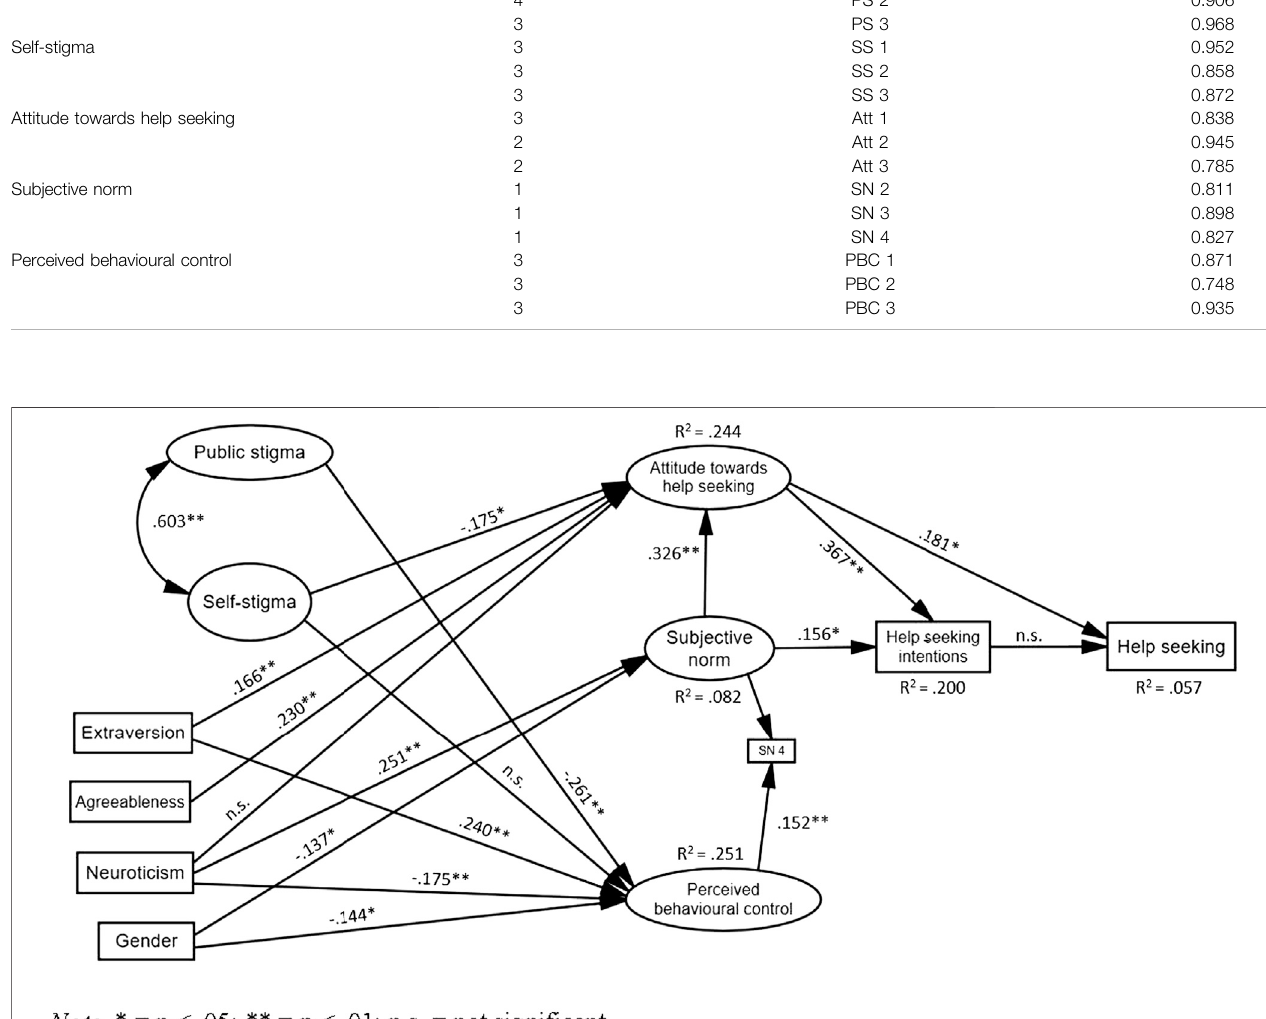
Frontiers in Education |